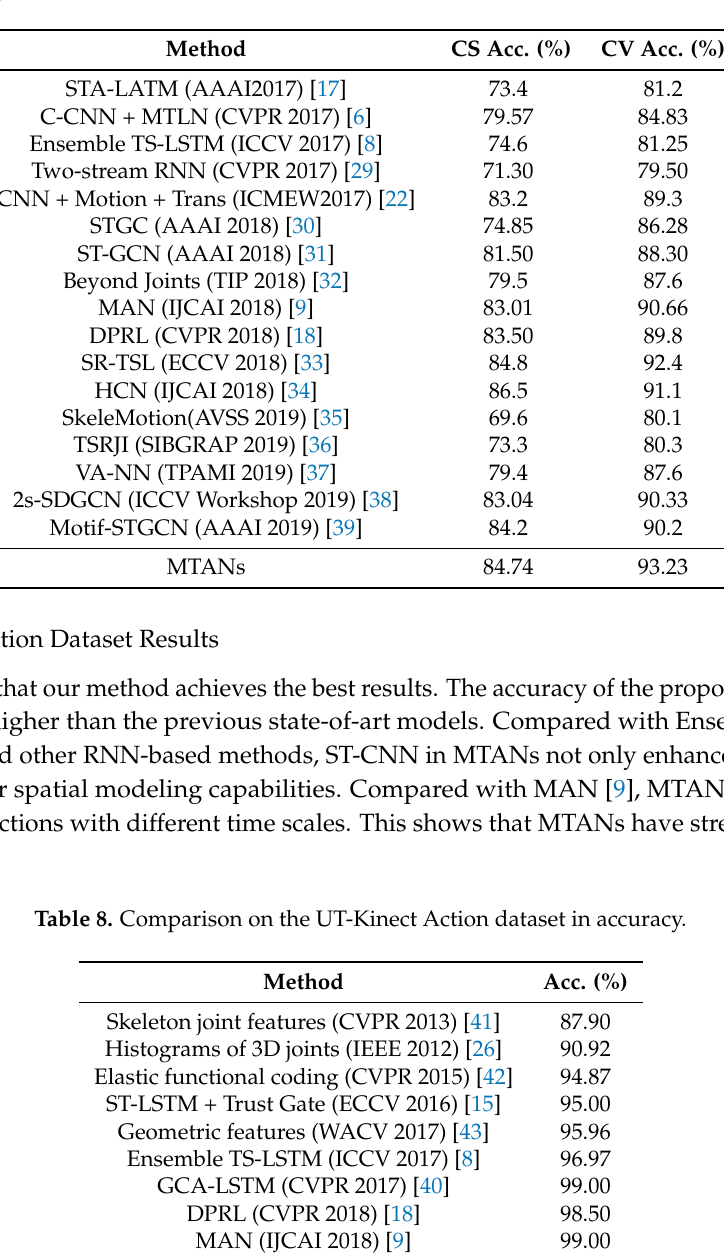
Table 7. Comparison on the NTU RGB+D dataset with CS evaluation and CV evaluation in accuracy.